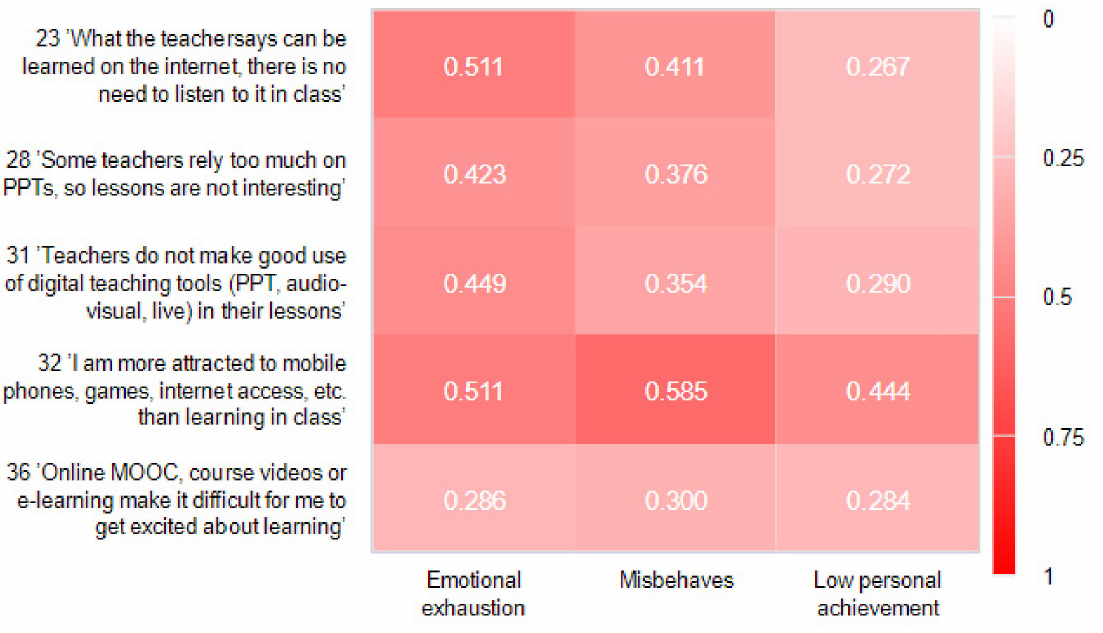
Figure 4. Pearson Correlation Analysis of Digital Instruction and College Students’ Class- room